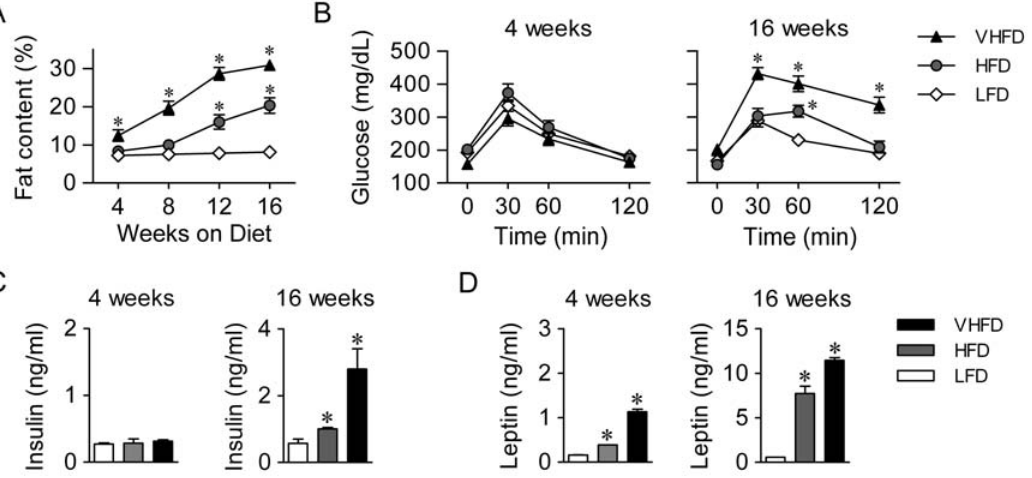
Figure 1. High-fat diet feeding elicits hyperleptinemia prior to hyperinsulimia. C57BL/6 male mice at 6 weeks of age were fed LFD, HFD and VHFD, respectively. (A) Body fat accumulation was monitored monthly by nuclear magnetic resonance (NMR) and shown as percentage of total body weight (n=15/group). (B) Glucose tolerance tests were performed in mice at 4 weeks (n=10/group) or 16 weeks (n=15/group) as indicated. (C, D) Serum concentrations of (C) insulin and (D) leptin were determined in mice maintained on the diets for 4 or 16 weeks (n=3–4/group). All data are presented as mean 6 SEM. * p , 0.05 vs. LFD-fed mice.